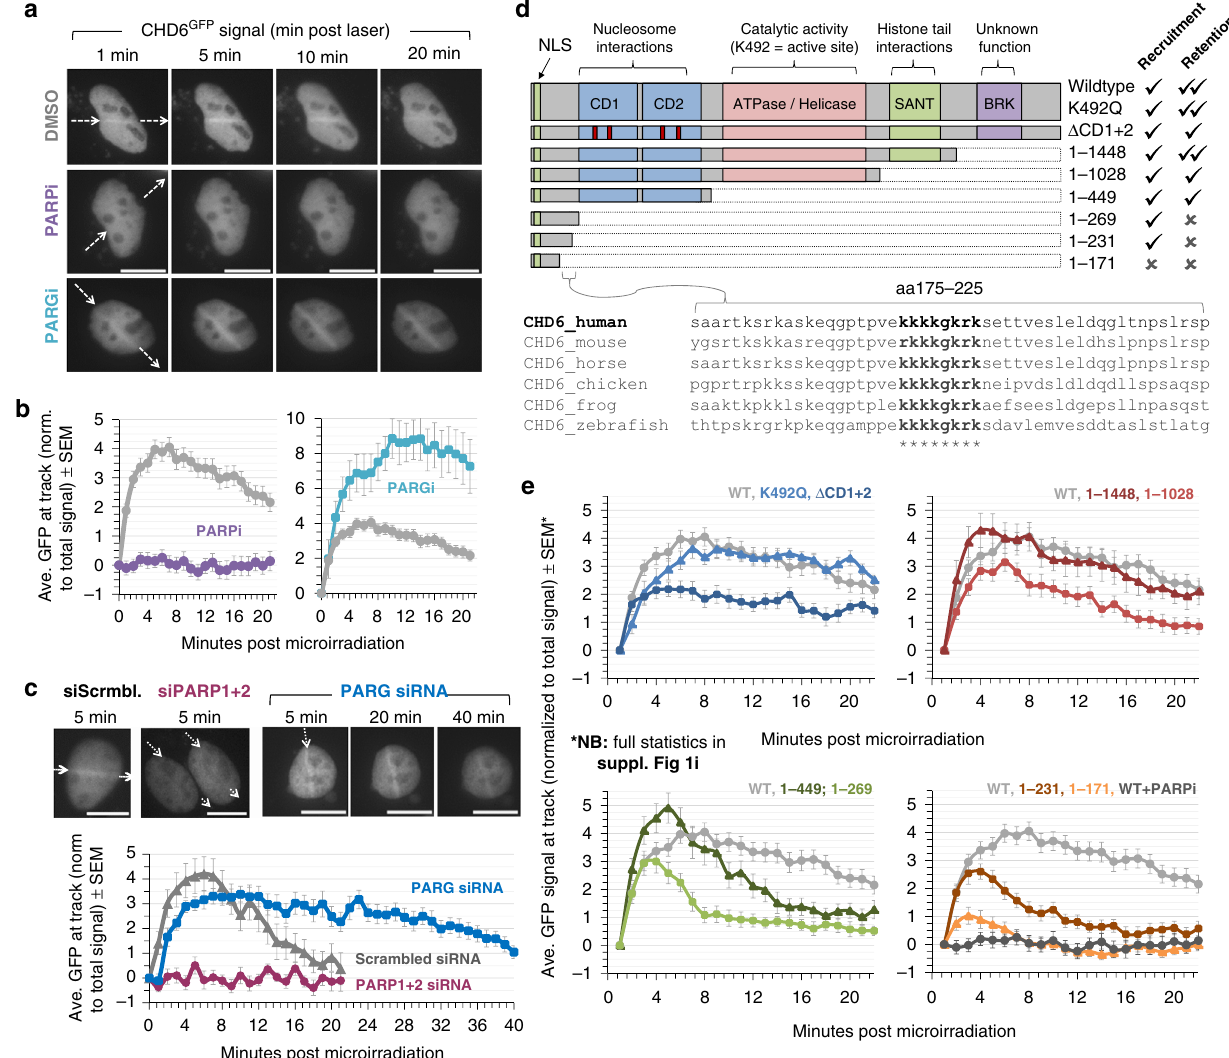
Fig. 3 CHD6 recruitment to DNA damage is PAR-dependent. a A549 expressing CHD6 GFP were treated with DMSO, PARP inhibitor (PARPi) or PARG inhibitor (PARGi) for 1 h before micro-irradiation and live imaging over 21 min. Scale bars equal 10 µ m. b Cells were quanti fi ed for GFP signal increase within the laser track as described in Methods. Gray lines indicate DMSO-treated cells; purple lines indicate PARPi-treated cells; cyan lines indicate PARGi-treated cells. Error bars = s.e.m.; n = 8 – 30. c A549 were transfected with indicated siRNAs and CHD6 GFP ; 16 h later, cells were microirradiated and live imaged and quanti fi ed as in ( a , b ). Scale bars equal 10 µ m. Gray lines indicate scrambled siRNA-treated cells; magenta lines indicate PARP1 and PARP2 siRNA-treated cells; blue lines indicate PARG siRNA-treated cells. Error bars = s.e.m.; n = 20. d Schematic of known CHD6 domains, including: catalytic dead (K492Q), double chromodomain ( Δ CD1 + 2) and truncation mutations. Cross-species alignment of the PAR-dependent recruitment region is expanded. e A549 expressing CHD6 mutants indicated in ( d ) were treated and analyzed as in ( a , b ). All error bars = s.e.m.; n = 12 – 53. Full statistical analysis for data in all panels is in Supplementary Table 1. Line colors are as follows: gray = WT; light blue = K492Q; dark blue = Δ CD1 + 2; dark red = 1 – 1448; light red = 1 – 1028; dark green = 1 – 449; light green = 1 – 269; dark orange = 1 – 231; light orange = 1 – 171; dark gray = WT treated with